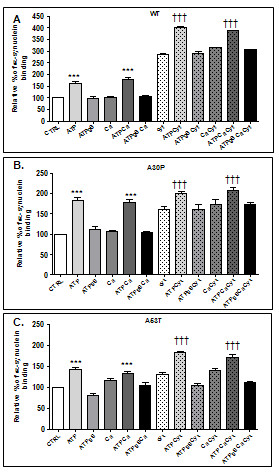
(A-C) Recombinant α-syn (Wt, A30P and A53T) were incubated with ATP (1 mM), ATPγS (3 mM), Ca2+ (1 mM), ATP/Ca2+ or ATPγS/Ca2+ in absence or presence of 1.5 mg/ml of KO cytosol, for 10 min at 37°C. Incubation with ATP (Student's T-test, p < 0.001), but not ATPγS or Ca++ (Student's T-test, p > 0.05), induced a significant increase in the binding of Wt and mutant forms of α-syn (compared to control condition without added cofactors).